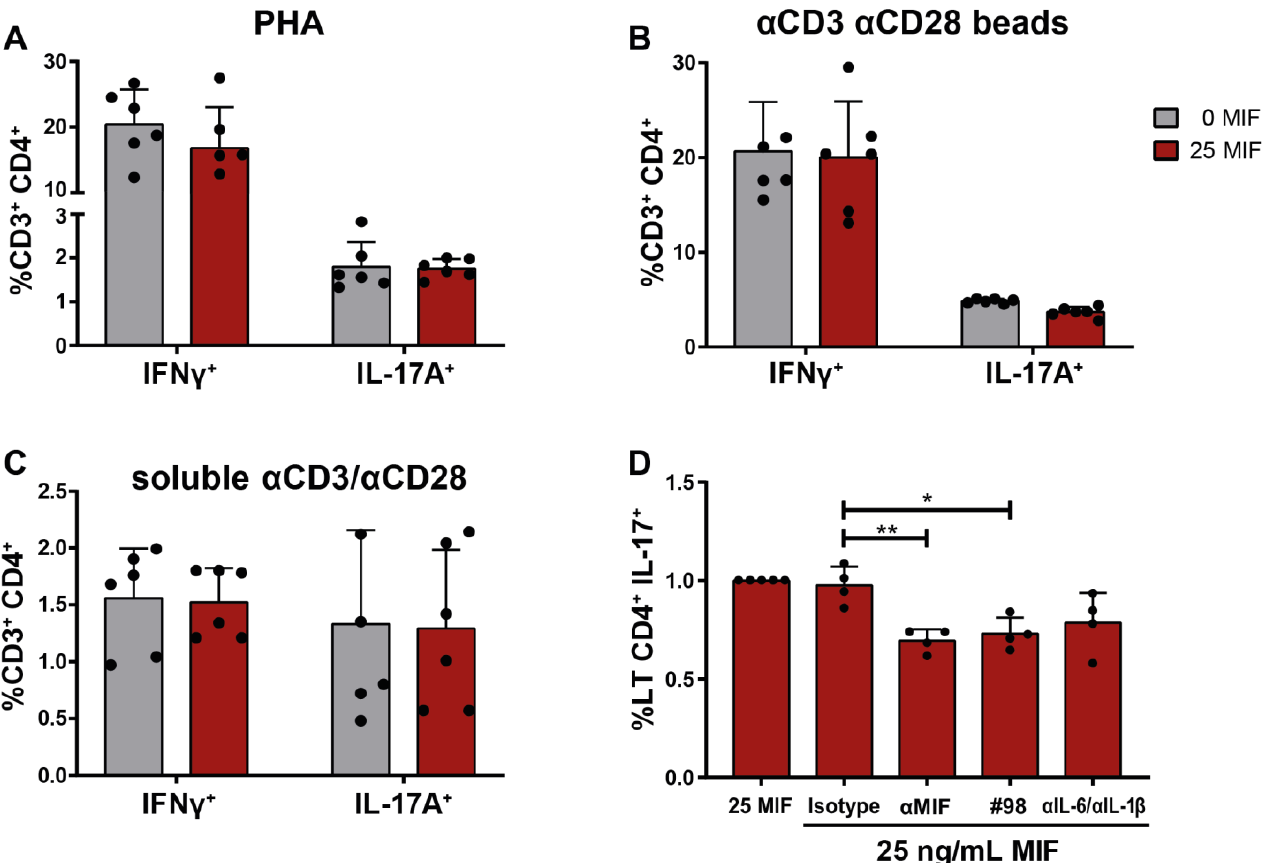
Figure 4. Study of the mechanism involved in Th17-like profile promotion. IL-17A and IFN γ -expressing CD4TLs after conditioning with HIV-infected MIF-stimulated MDM-derived supernatant in parallel with ( A ) PHA stimulation, ( B ) CD3/CD28-engaging beads stimulation and ( C ) CD3/CD28-engaging antibodies stimulation. ( D ) Proportion of IL-17A-producing CD4TLs after MIF blocking in the context of an MIF-treated cell co-culture. From left to right: cell co-culture control with 25 ng/mL of MIF, immunoglobulin isotype control, MIF-neutralizing monoclonal antibody, MIF chemical antagonist (#98), IL-6 and IL- 1β neutralizing monoclonal antibodies. Each point represents an independent experiment comprising triplicates. Bars indicate the mean ± SD of all independent experiments each one performed in triplicate. Data analysis was performed by a one-way ANOVA and Tukey’s post -test (excluding the positive control). * p < 0.05, ** p < 0.01.